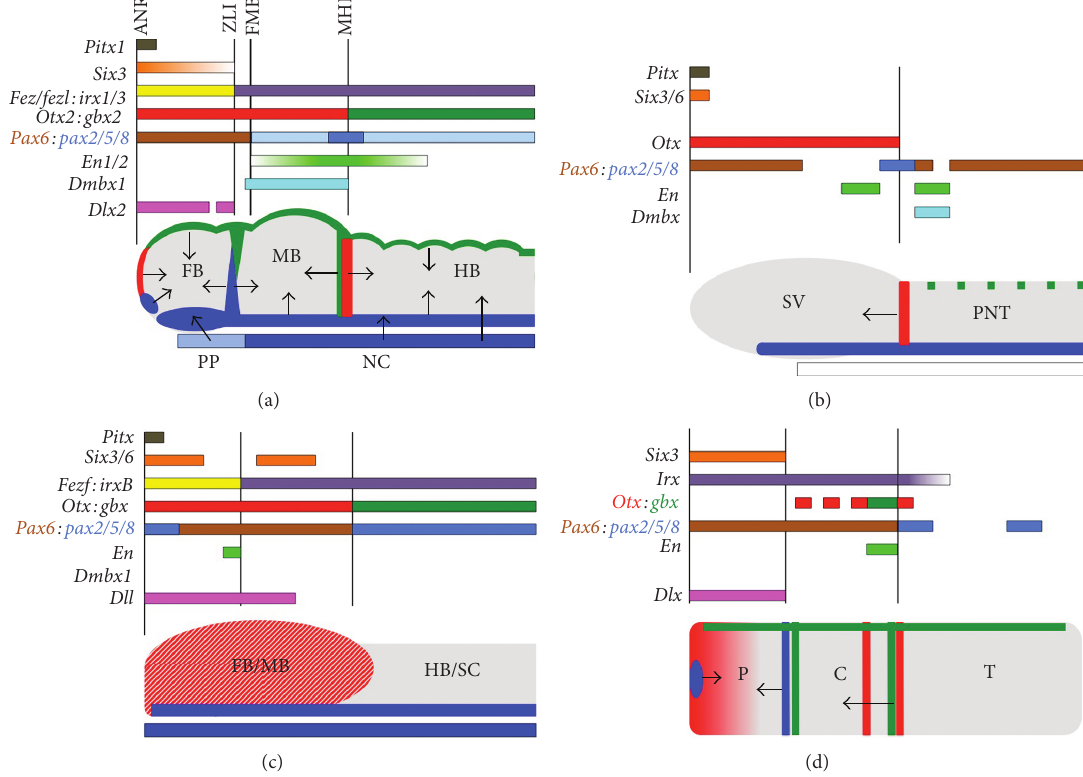
F 1: Expression of patterning genes and topography of secondary organisers in four deuterostome lineages. (a) Vertebrate neural tube, (b) ascidian nerve cord, (c) amphioxus nerve cord, and (d) Saccoglossus kowalevskii larva. ANR: anterior neural ridge, C: collar, FB: forebrain, FMB: forebrain-midbrain boundary, HB: hindbrain, MB: midbrain, MHB: midbrain-hindbrain boundary, NC: notochord, P: proboscis, PNT: posterior neural tube, PP: prechordal plate, SC: spinal cord, SV: sensory vesicle, T: trunk, and ZLI: zona limitans intrathalamica. Signalling centres express Bmps and Wnts (green), Fgfs (red) or Hh (blue); arrows indicate that a signalling function has been experimentally demonstrated. For gene names and references see